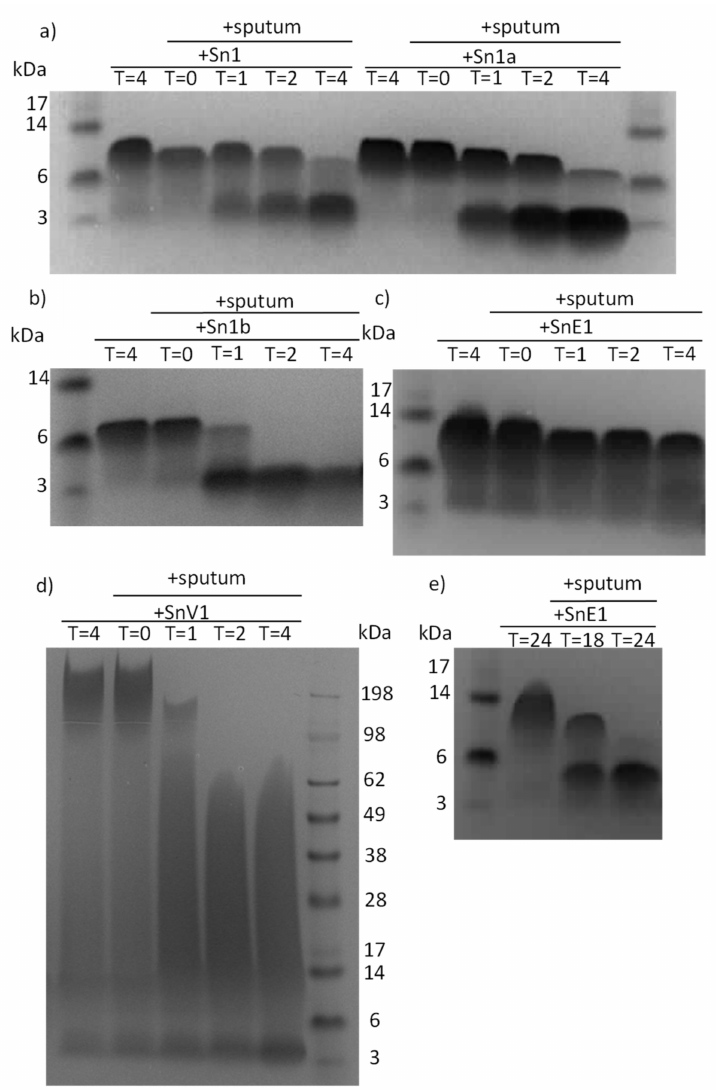
Figure 1. SDS-PAGE gels of peptides incubated with CF sputum. ( a ) Sn1, Sn1a, ( b ) Sn1b, ( c ) SnE1 and ( d ) SnV1 were incubated with CF sputum at 37 ◦ C for 0–4 h, with samples taken at hourly time points. ( e ) SnE1 was incubated with CF sputum at 37 ◦ C for 18–24 h, with samples taken at 18 and 24 h. Samples then underwent electrophoresis and stained with Coomassie stain to allow